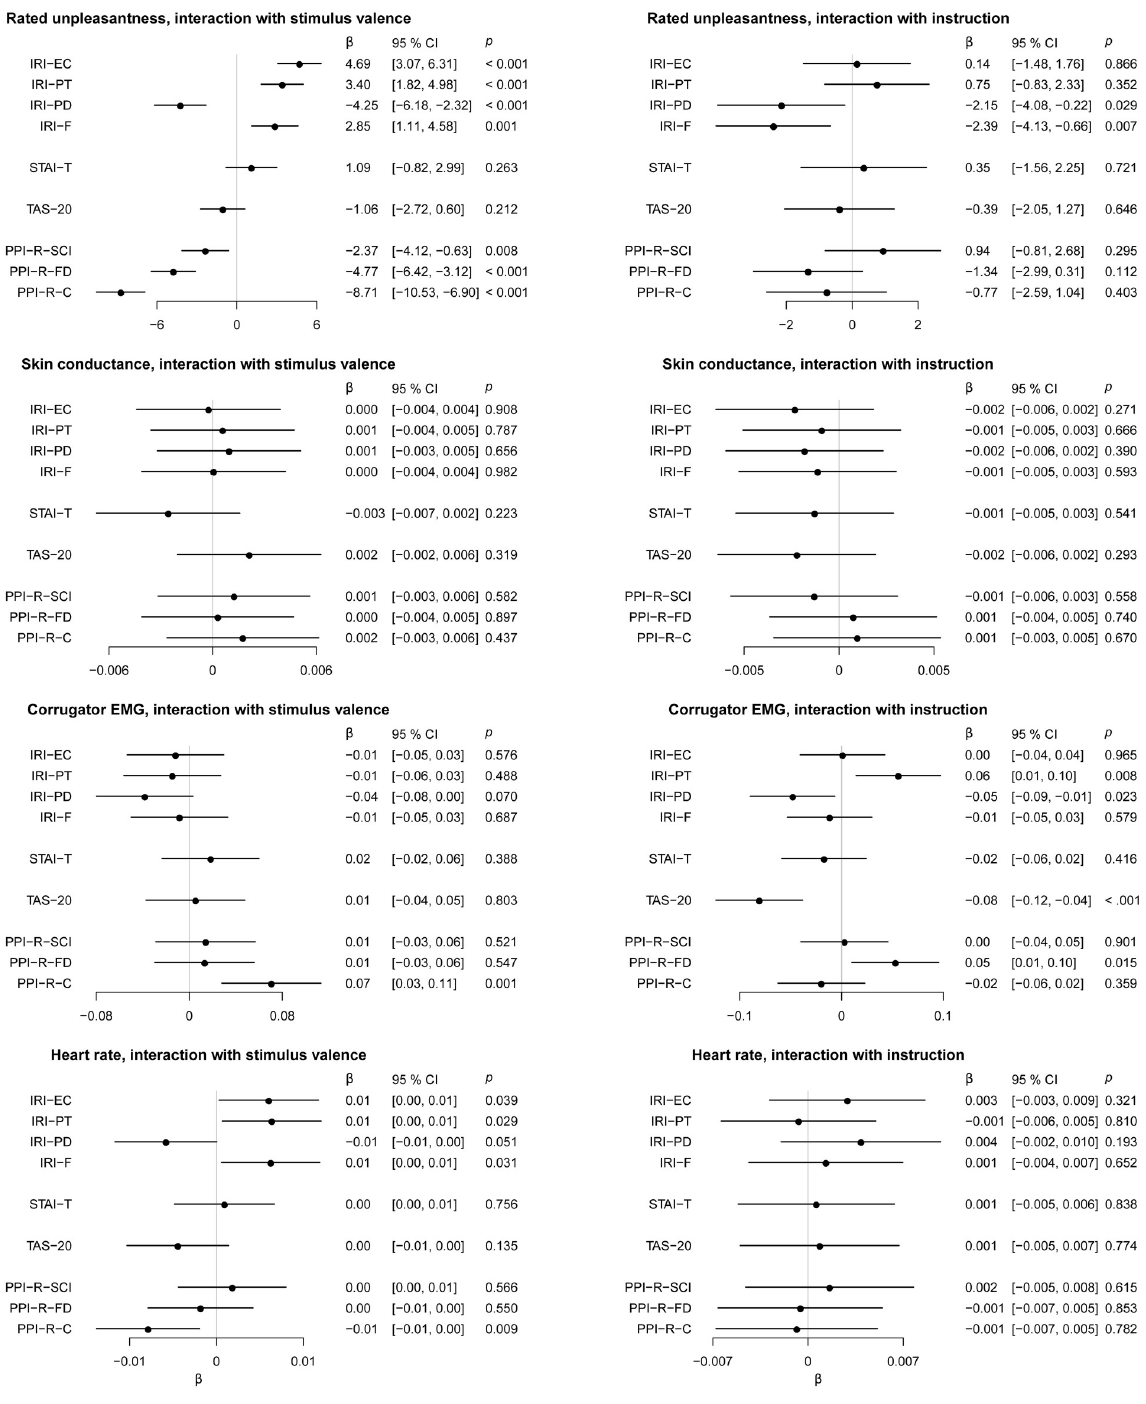
Fig 9. Interaction effects of self-rated personality traits with stimulus valence and reappraisal instruction. Effects shown are standardized regression coefficients with 95% confidence intervals.